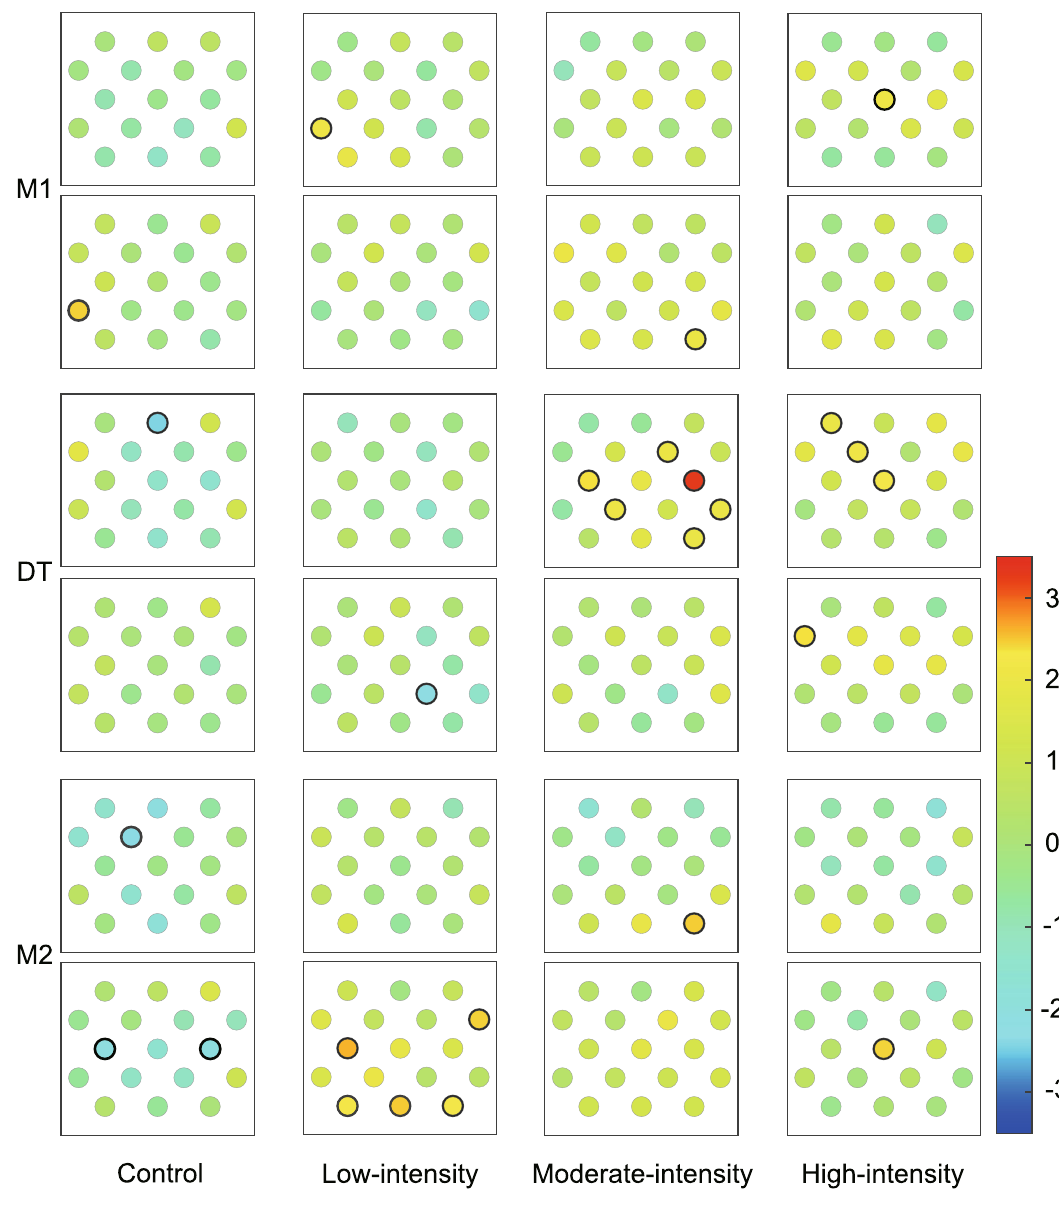
Figure 2. Topographical maps of PFC activation under control, low-intensity, moderate-intensity, and high- intensity conditions. The circles represent channels, the locations of which correspond to the channels shown in Fig. 1. The color bar indicates the t-value, which indicates the increase or decrease in oxy-Hb concentration from the resting period. The bluish color indicates the decrease in oxy-Hb concentration during the task (M1, DT, and M2) relative to the resting period, whereas the reddish color indicates the increase. The channel with a significant difference is outlined with a thicker black circle ( p < .05). We separately analyzed the concentration of oxy-Hb during the first and second halves of M1, DT, and M2. The upper panels of each of the periods M1, DT, and M2 in the figure show the results of the first half and the lower panels show those of the second